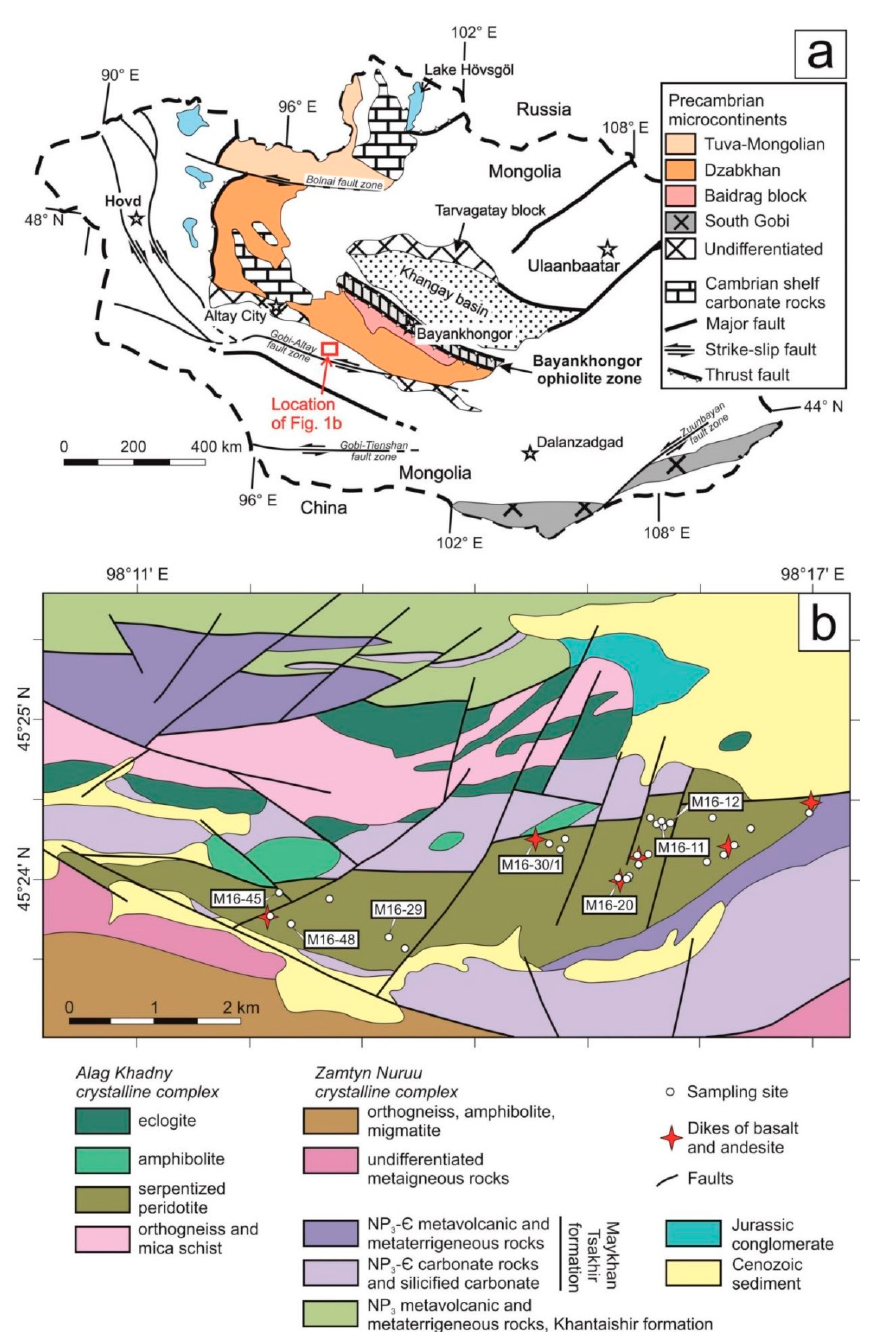
Figure 1. Simplified tectonic map of Mongolia, with the location of the Alag Khadny complex [35] ( a ), and a geological scheme of the study area ( b ), modified after [25,30].